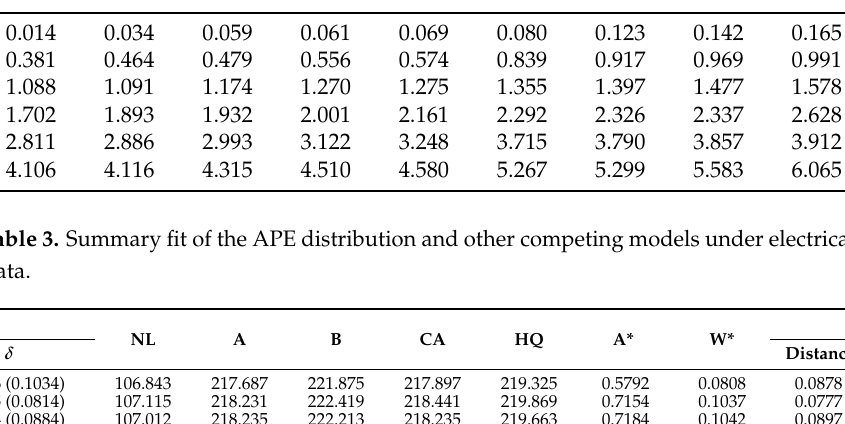
Table 2. Time points of 60 electrical appliances.